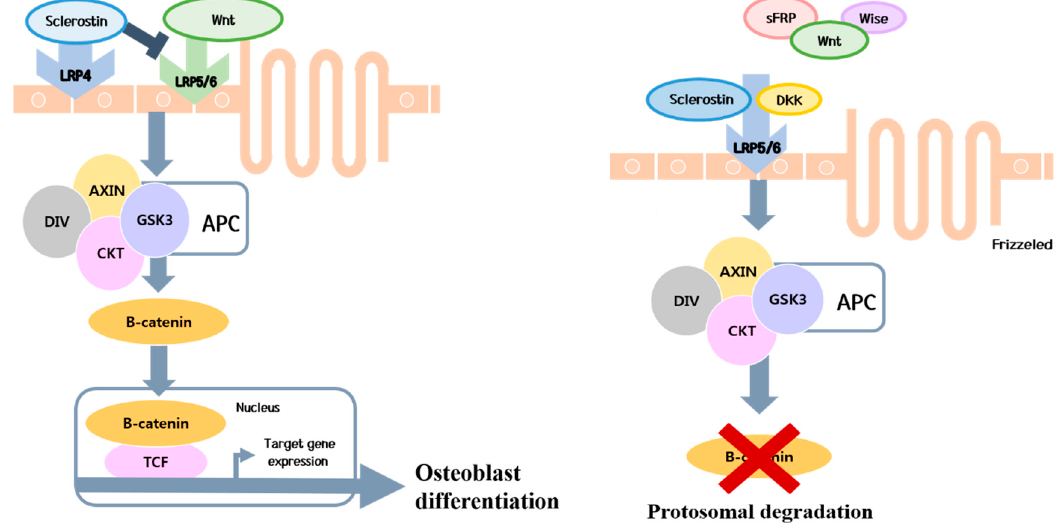
Figure 2. Effects of sclerostin on osteoblast differentiation. Sclerostin produced by osteocytes inhibits Wnt/ β -catenin signaling during early bone diseases in patients with cholestatic diseases [3]. This soluble protein is produced by osteocytes that differentiated from osteoblasts and prevents Wnt from binding to low-density lipoprotein receptor-related proteins-5/6 (LRP5/6) transmembrane receptors. This blockade prevents Wnt signaling and osteoblast differentiation to inhibit bone formation. LRP: lipoprotein receptor-related proteins; GSK3: glycogen synthase kinase 3, DKK: Dickkopf; sFRP: secreted frizzled-related protein; APC: adenomatosis polyposis coli; TCF: T-cell specific transcription factor.